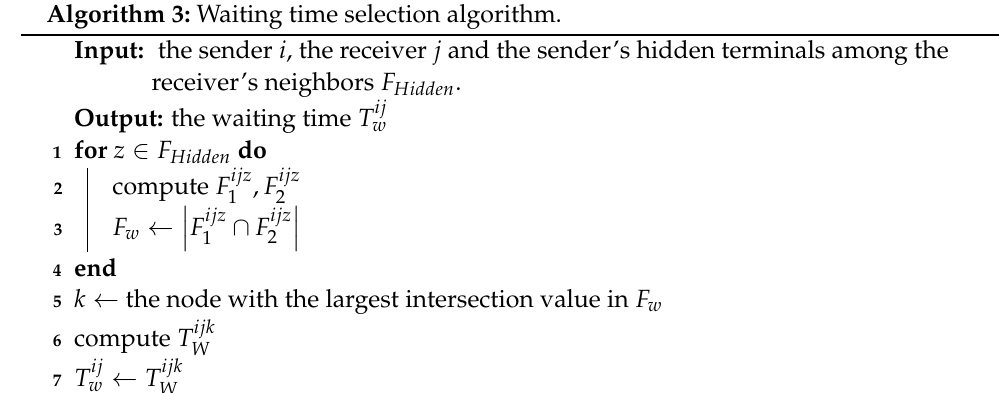
Algorithm 3: Waiting time selection